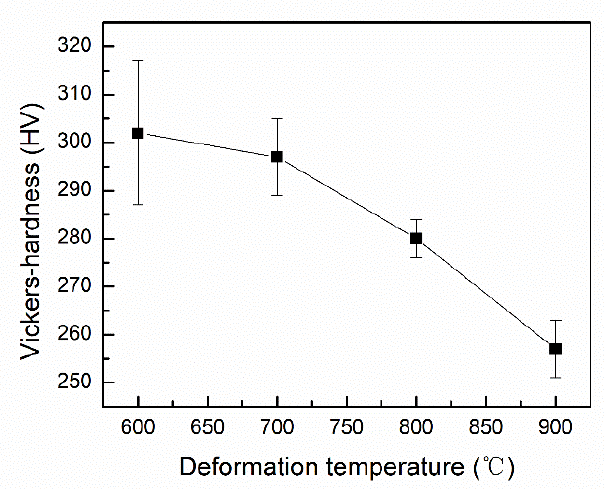
Figure 10. Vickers hardness of the low-carbon ferritic stainless steel samples deformed at the different temperatures.